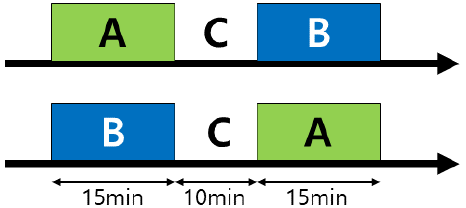
Figure 1. Process for measuring the practice of the participants. Both Juingong meditation (A) and IMW (B) lasted for 15 min. C was a 10 min break. Both states A and B were conducted in the same sitting posture. EEG was not measured during pre and post meditation or IMW. The EEG was meas- ured only during the meditation (A) and IMW (B)